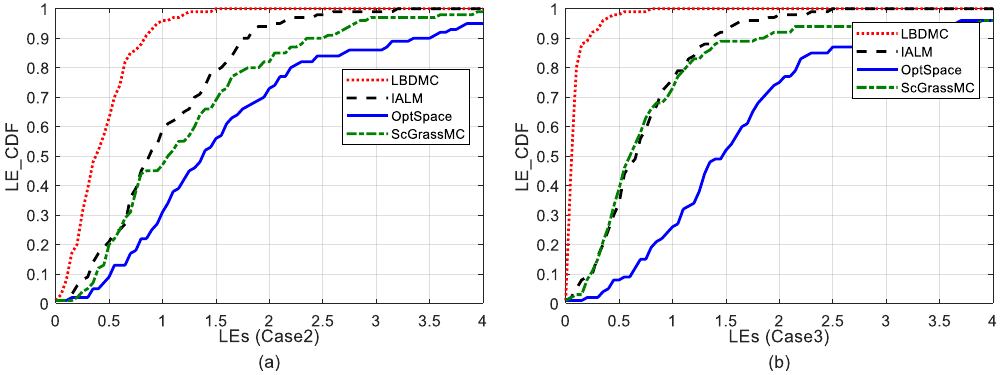
Figure 7. Comparison of localization error cumulative distributions. The sampling rate is fixed at 30%: ( a ) Localization errors cumulative distribution under Case 2; ( b ) Localization error cumulative distribution under Case 3.